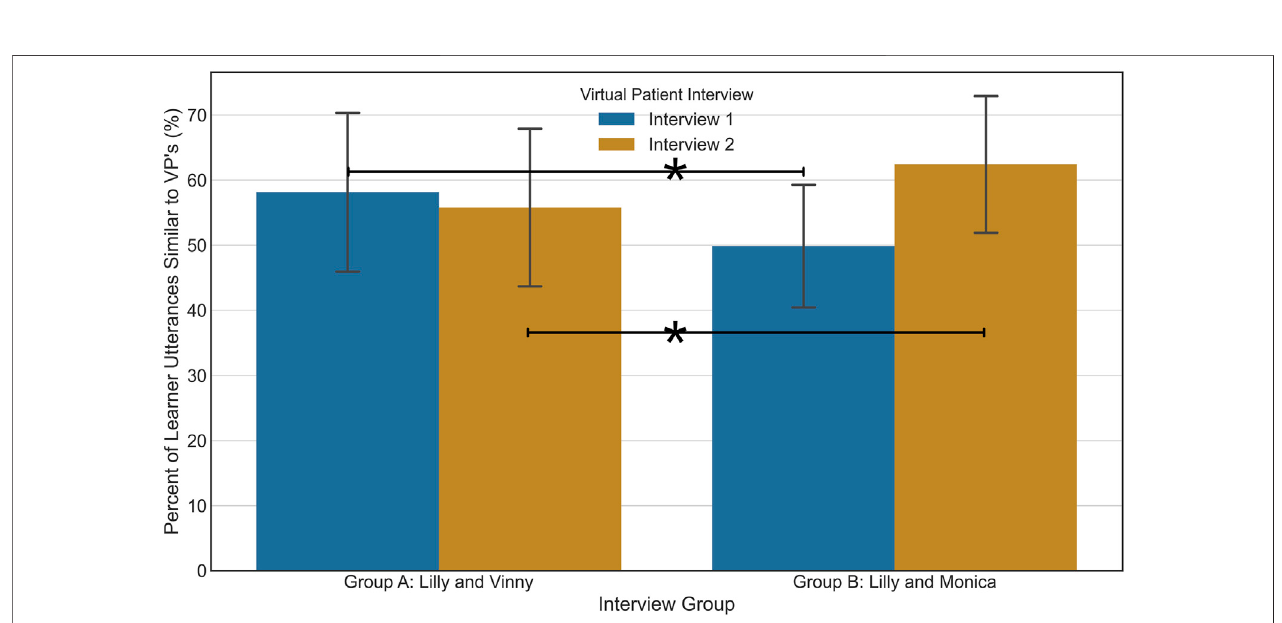
FIGURE7| Themeansandstandarddeviationsofpercentoflearnerutterancessimilartothevirtualpatient ’ sforstudentsintheMessageProductionTrendsstudy.